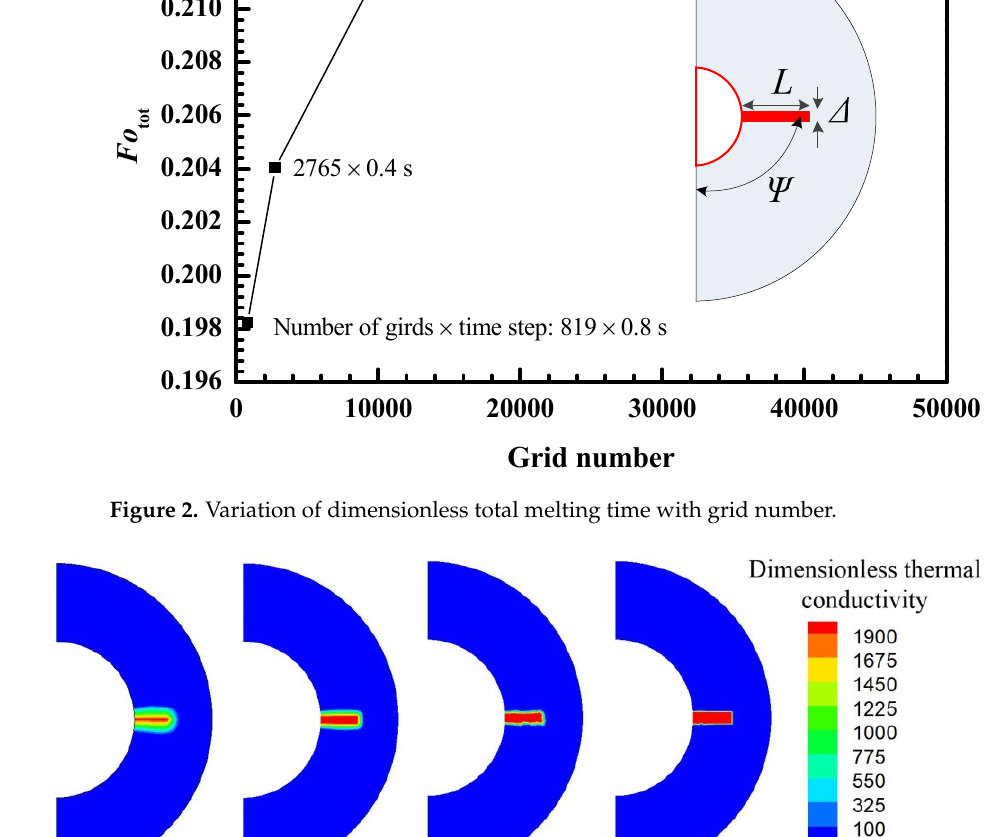
Figure 2. Variation of dimensionless total melting time with grid number.